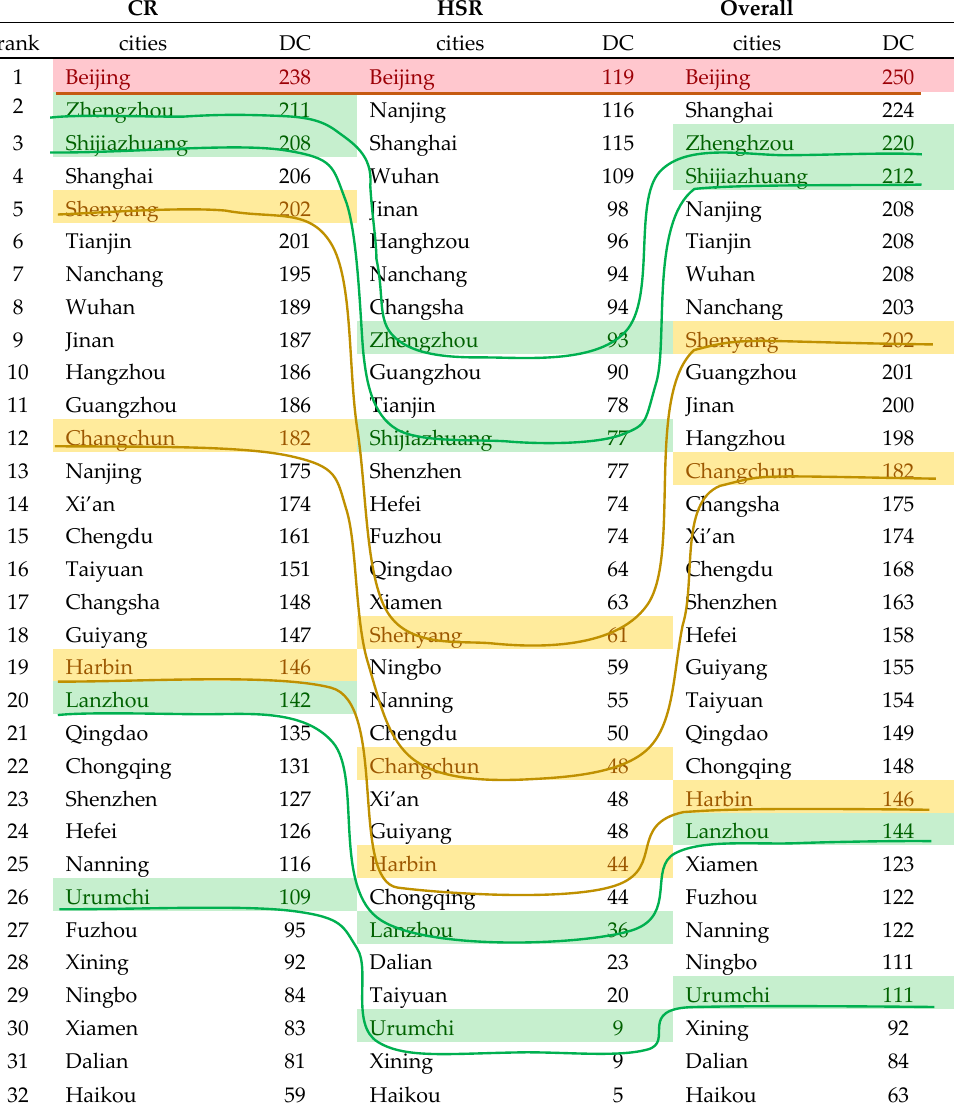
Table 4. Changes in rankings of cities by train type.